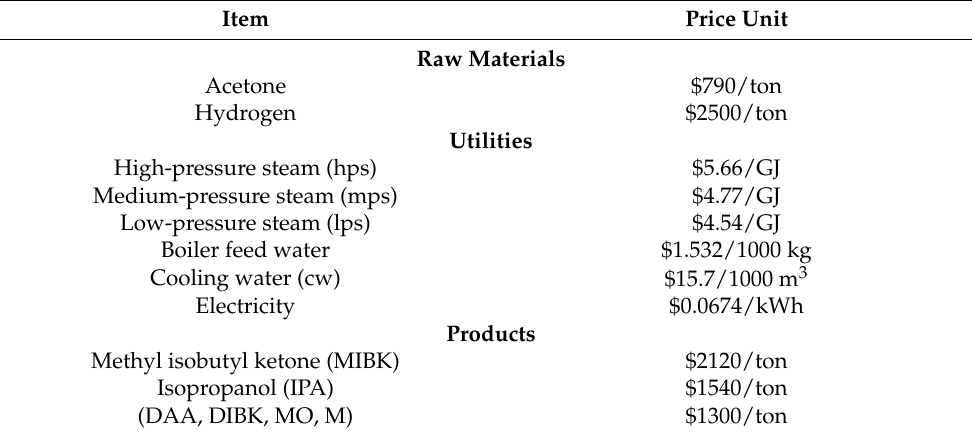
Table 3. Cost input for the developed MIBK process